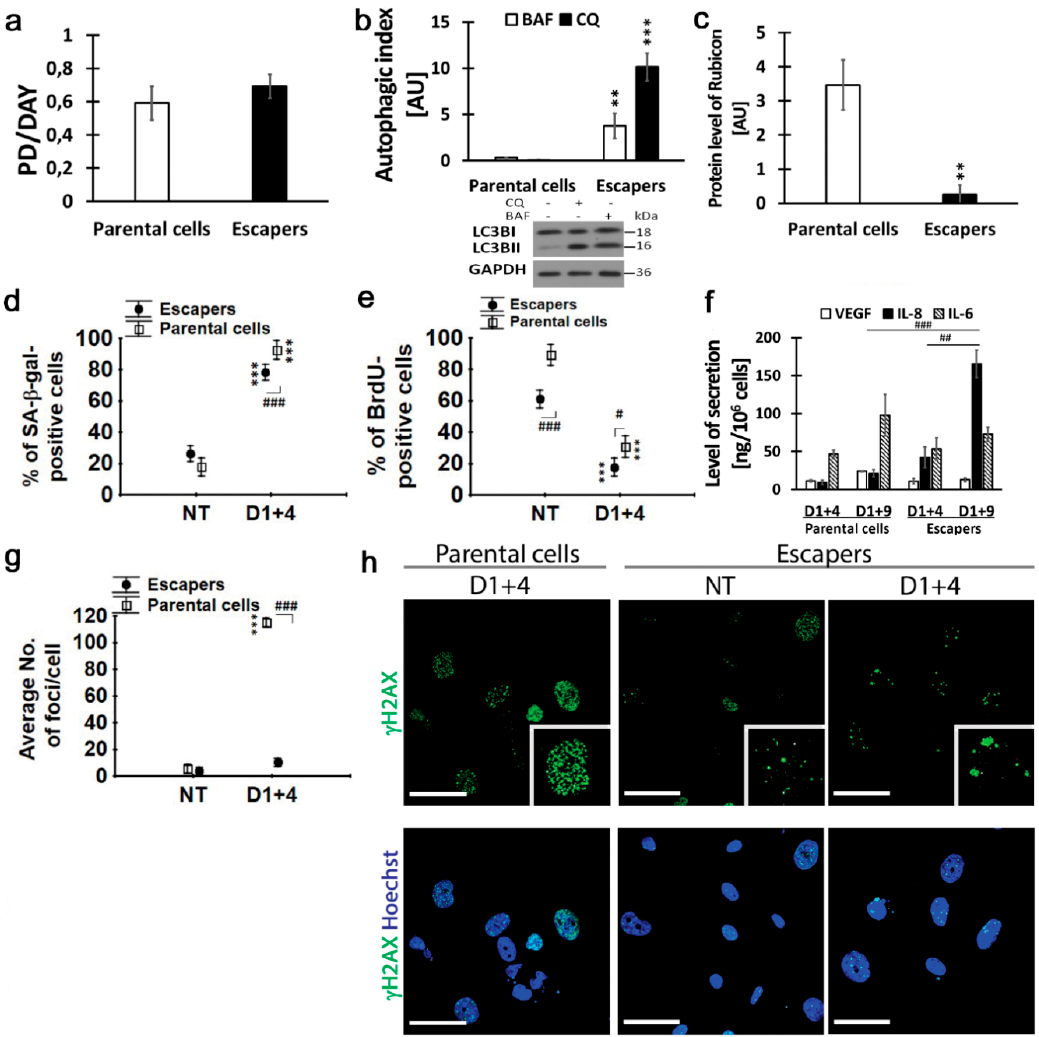
Figure 7. Comparison of parental MDA-MB-231 cells and escapers. Parental cells and escapers were treated with 100 nM doxorubicin for 24 h, then cultured in a fresh medium and analyzed on the 4th day (D1+4). ( a ) Analysis of population doublings per day. ( b ) Quantitative analysis of autophagic index based on densitometry of LC3B protein level in untreated and bafilomycin A (BAF)- or chloroquine (CQ)-treated cells. ( c ) The protein level of Rubicon; densitometry analysis of western blot bands from four independent experiments. ( d , e ) Percentage of SA- β -gal- and BrdU-positive cells. Data are calculated as the percentage of the total cell population. ( f ) Amount of IL-8, IL-6 and VEGF secreted by cells on consecutive days after doxorubicin treatment. ( g ) The average number of γ H2AX foci per cell. ( h ) Representative immunofluorescence images of parental cells and escapers stained for γ H2AX (green) and Hoechst (blue). Scale bars: 50 μ m. Statistics: bars: mean value, error bars: SEM, each point: mean value ± 0.95 confidence interval, n = 4. Statistical significance (in relation to non-treated (NT) or parental cells): ** p < 0.01, *** p < 0.001, between samples: # p < 0.05, ## p < 0.01, ### p < 0.001